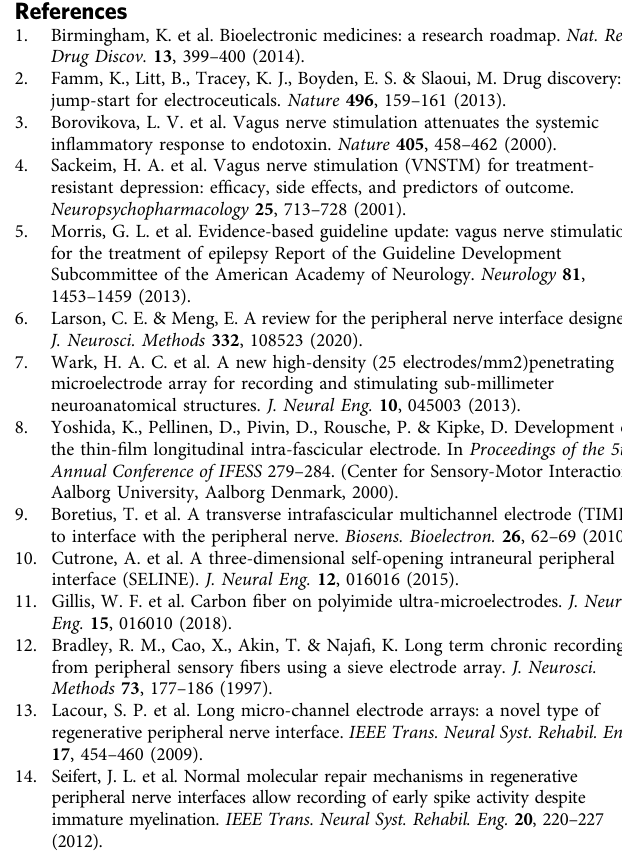
Figure 3e: comparison of stimulation evoked response amplitudes before and after lidocaine/saline application in n = 3 birds. Mauchley ’ s test indicated a violation of sphericity ( W = 0, P = 0), and a Huynh – Feldt degree of freedom correction was applied. Subsequent repeated-measures ANOVA revealed signi fi cant differences between the treatments ( F (1.11,2.21) = 189.02, P = 0.003). Post hoc comparisons using Dunnett ’ s test showed signi fi cant differences between saline (control) and lidocaine application ( P = 6 ×10 − 6 ); no other condition signi fi cantly differed from control ( P >0.15). Figure 4e: quanti fi cation of the stability of nXIIts dynamics, Vpp, SNR, and event rate over 30 days of continuous recording in n = 3 birds; no statistics were found to change signi fi cantly from day 1 over the duration of the experiment. A two-tailed, paired t -test revealed no signi fi cant differences in correlation between